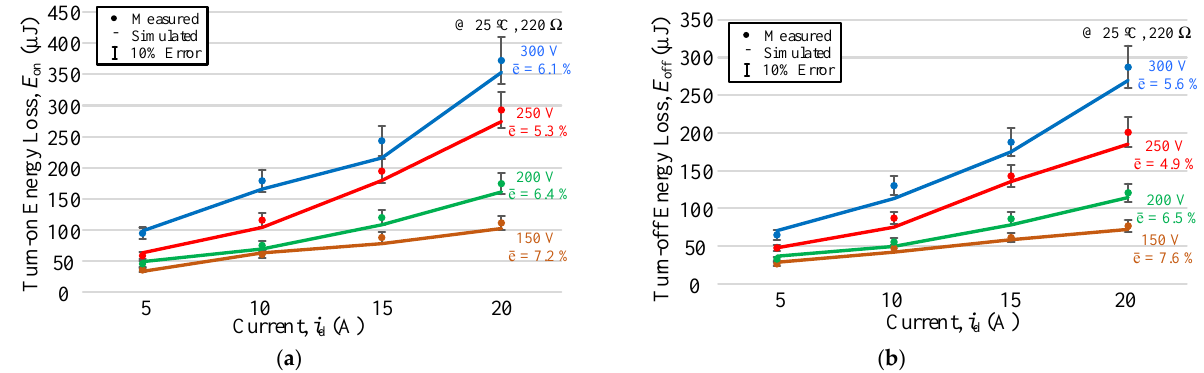
Figure 18. Power loss results of eGaN HEMT with SiC SBD ( a ) turn on, ( b ) turn off.